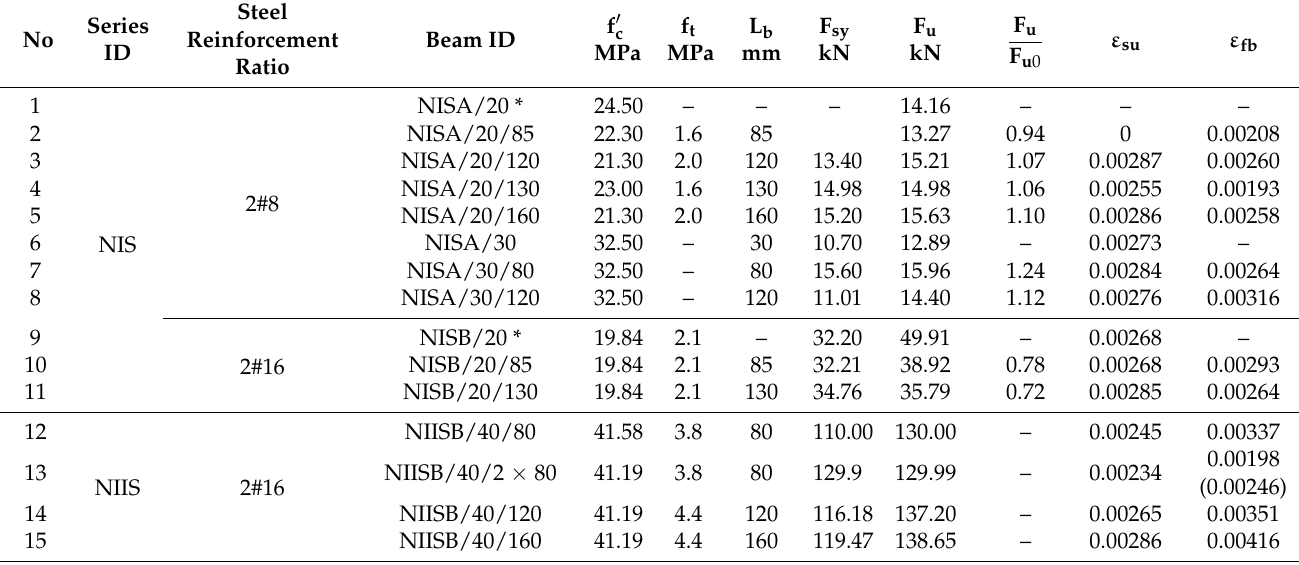
Table 2. Concrete properties and test results